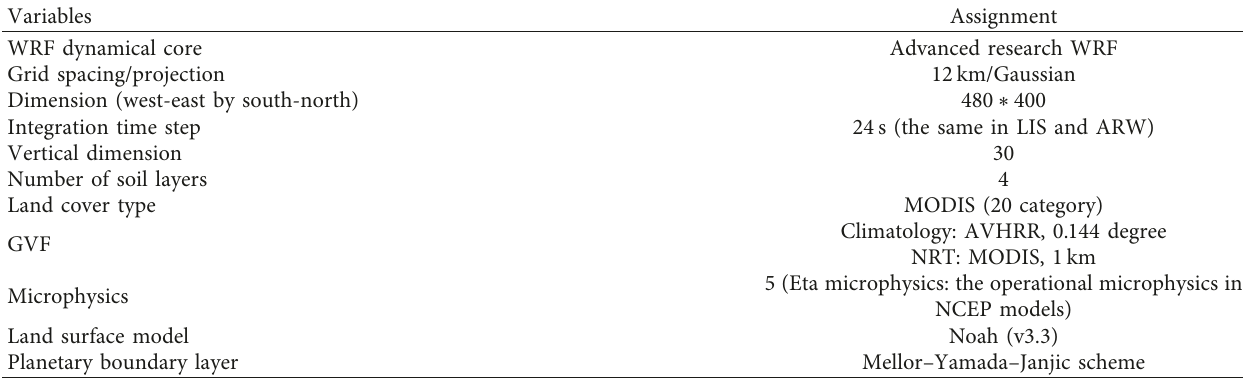
Table 1: LIS-WRF model configuration